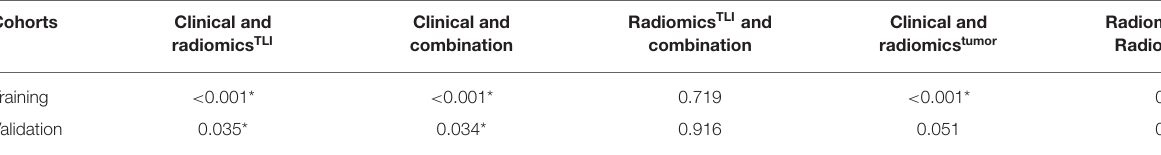
TABLE 5 | Delong tests’ results between different models.